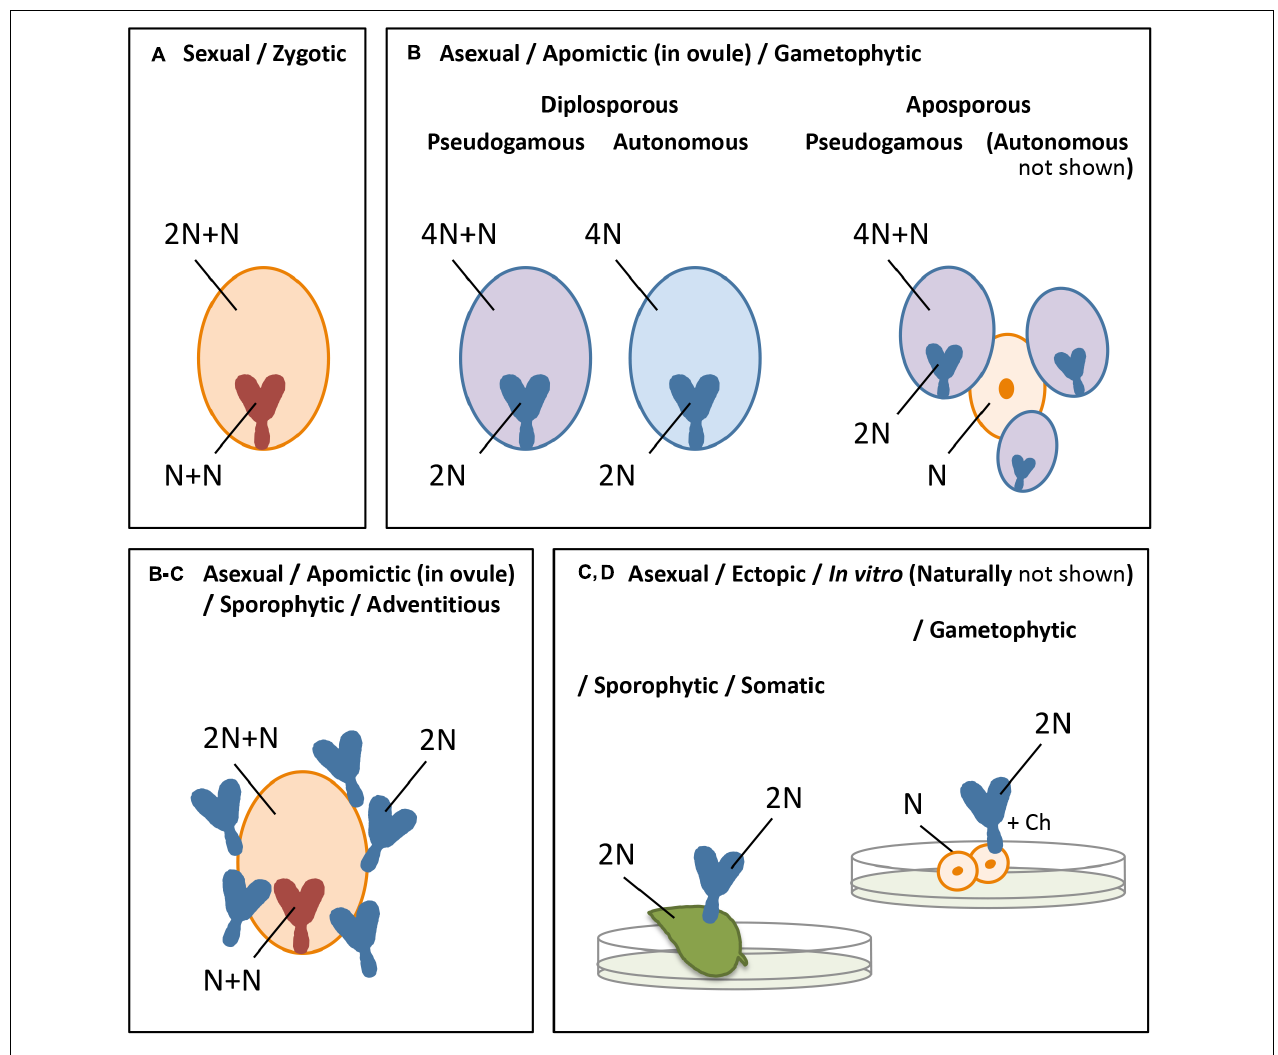
FIGURE 1 | Summary of the different forms of embryogenesis in plants, showing the embryo and endosperm originated from a mature embryo sac (A,B) or the embryo ectopically (C,D) after sexual (A) or asexual (B–D) reproduction, with orange indicating the sexual process, blue the asexual or apomictic process, pink apomictic reproduction with fertilization of the central cell, and N = chromosome set after reduction division: (A) zygotic embryogenesis , involving chromosome reduction (N) and gamete fusion (N + N for the embryo, 2N + N for the endosperm), (B) apomictic embryogenesis , occurring in the ovule, either gametophytic apomixis in which an embryo sac arises from an unreduced megaspore (diplospory) or sporophytic cell of the ovule, usually adjacent to a sexually derived spore or developing embryo sac (apospory), and parthenogenetic (spontaneous) embryo development and autonomous (spontaneous) or pseudogamous (after fertilization of the central cell) endosperm formation, or sporophytic apomixis in which the embryo arises directly from a sporophytic cell of the ovule, often as polyembryony and alongside a sexually derived embryo and endosperm (C) somatic / sporophytic embryogenesis , involving ectopic embryo development from sporophytic cells, and (D) gametophytic embryogenesis , idem from a gametophytic cell. The latter two (C,D) omit the formation of an embryo sac, endosperm, and a seed coat, and occur naturally, for example, from leaf margins or ovular cells (C) , gametophytic tissue in lower plants or, e.g., a synergid (D) , but are particularly known from in vitro embryogenesis in which embryos are formed in culture, after external induction, particularly from protoplasts, leaf, the hypocotyl or other plant tissues (C) , or microspores (D)